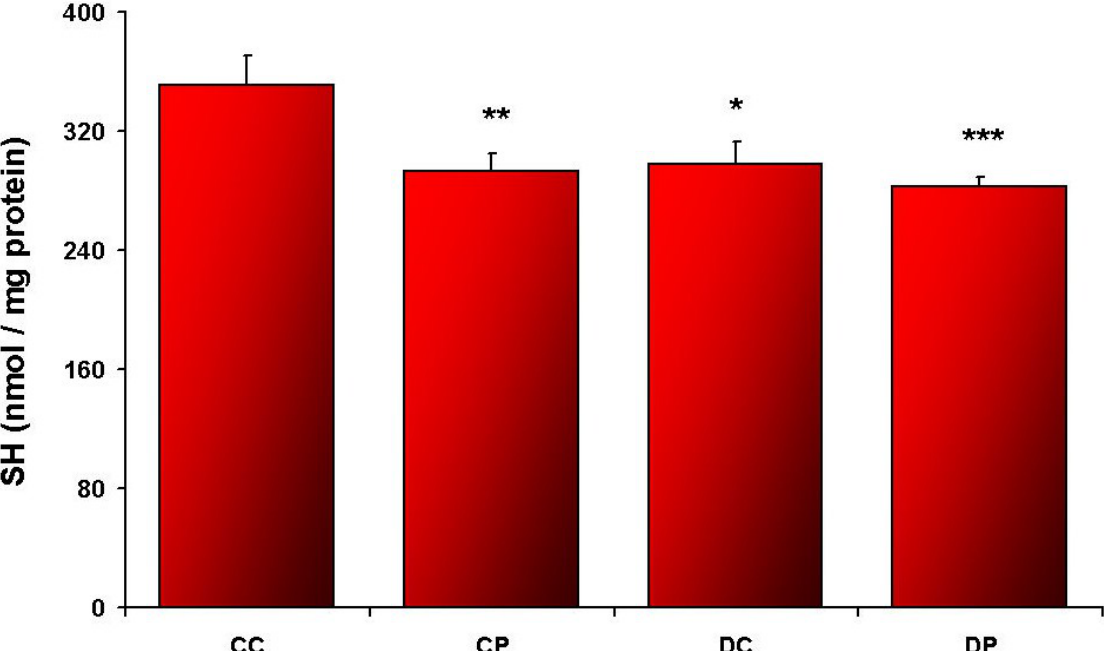
Figure 3. Sulfhydryl groups concentration in SOL muscle; control diet (CC), control diet and EtP (CP), HFD (DC), HFD and EtP (DP). Values are means ± SE. * p < 0.05